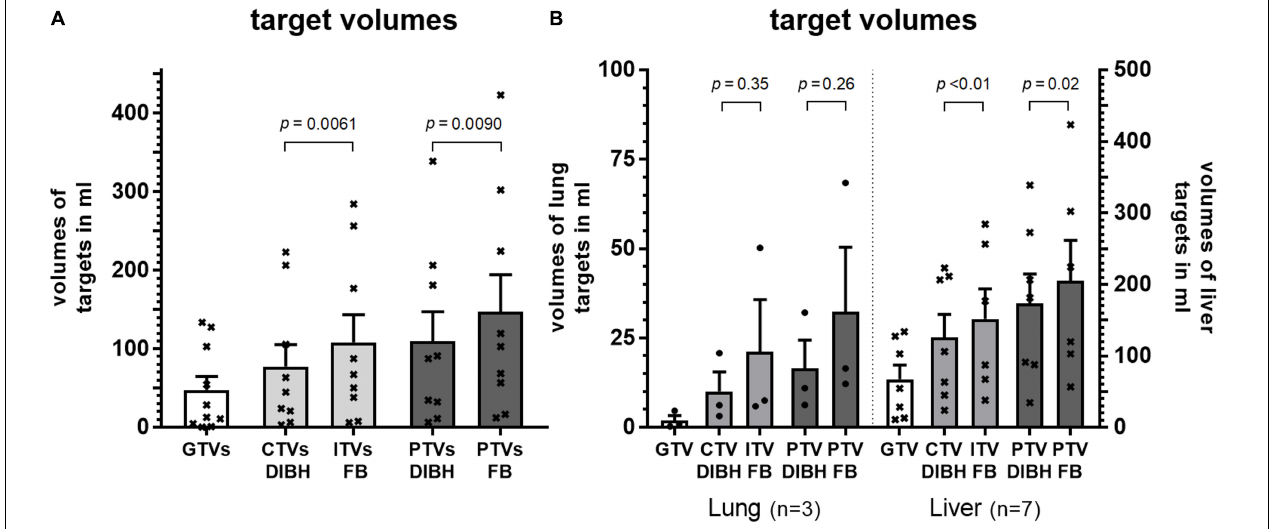
FIGURE 4 | Volumes of gross tumor (GTV), clinical target volume (CTV), internal target volume (ITV) and planning target in DIBH (CTV DIBH and PTV DIBH) as well as in free-breathing (ITV FB and PTV FB) for (A) all patients and (B) grouped by target location. Statistical differences were calculated by paired t